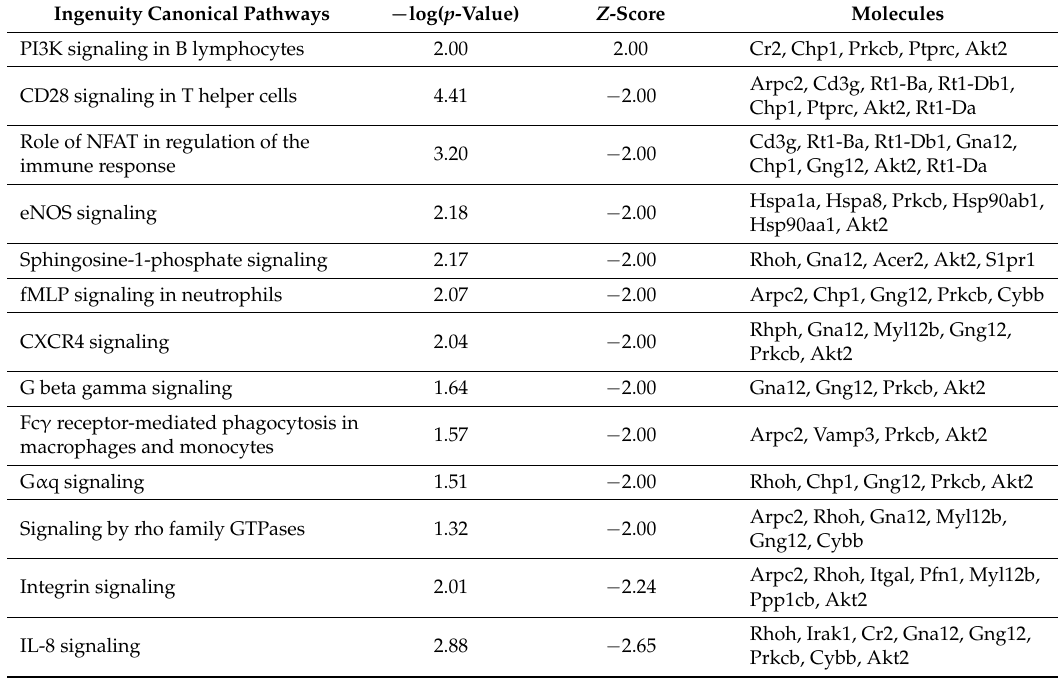
Table 2. Significantly regulated pathways in blood derived from differentially expressed genes. Ingenuity Canonical Pathways